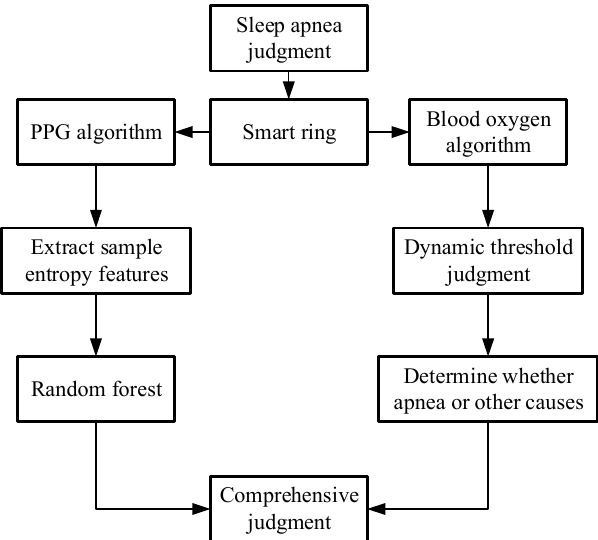
Figure 6. Flow chart of the comprehensive judgement algorithm for apnea.